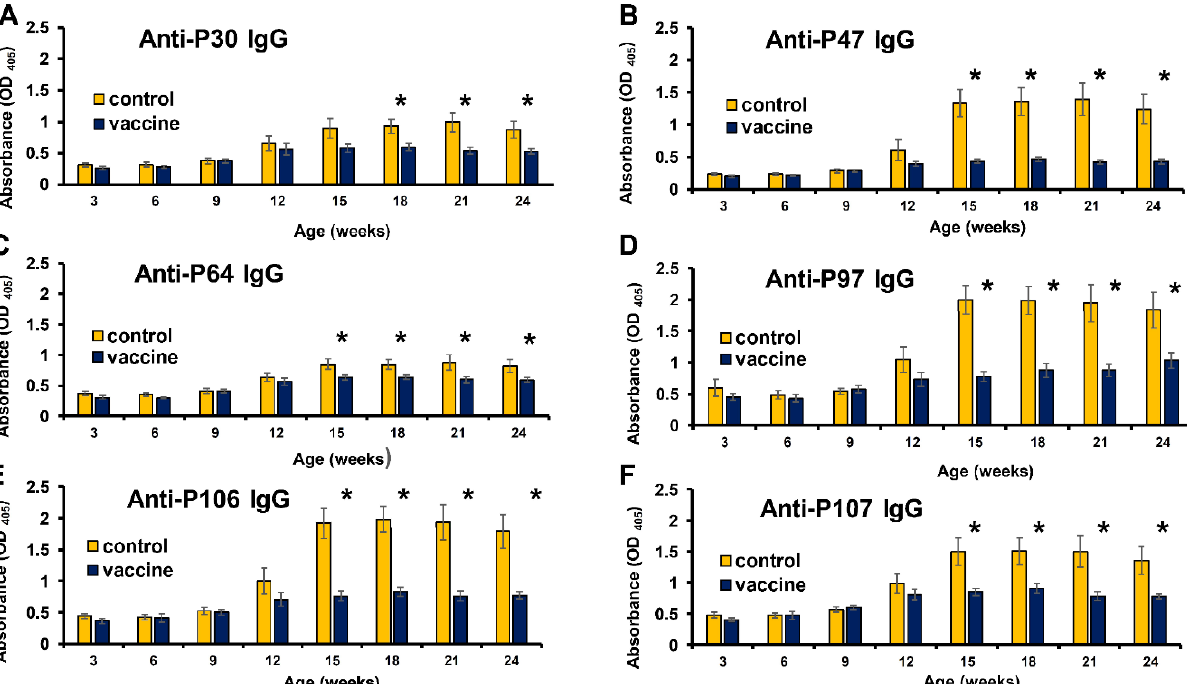
Figure 5. Comparison of anti-C-terminus of the capsid peptide-specific IgGs between two groups of pigs at different ages. Among vaccinated ( n = 10) and control ( n = 10) animals, the anti-PCV2 peptide-specific IgGs were detected in the serum samples from pigs at different ages (3, 6, 9, 12, 15, 18, 21, and 24 weeks of age). The C-terminus of the capsid peptides (P30, P47, P64, P97, P106, and P107) were used as coating antigens in the iELISA test. The peptide P30 had a significantly higher binding interaction with pig sera from the control group than with sera from the vaccine group aged 18 weeks to 24 weeks ( A ). Further, the others (P47, P64, P97, P106, and P107) also had a similar effect on pig sera aged 15 weeks to 24 weeks ( B – F ). The data were analyzed by using ANOVA and Tukey’s Studentized Range multiple comparisons test using the SAS Enterprise Guide 7.1 ® software. The data represent the mean ± standard error. Significant p values are indicated as * p < 0.05.